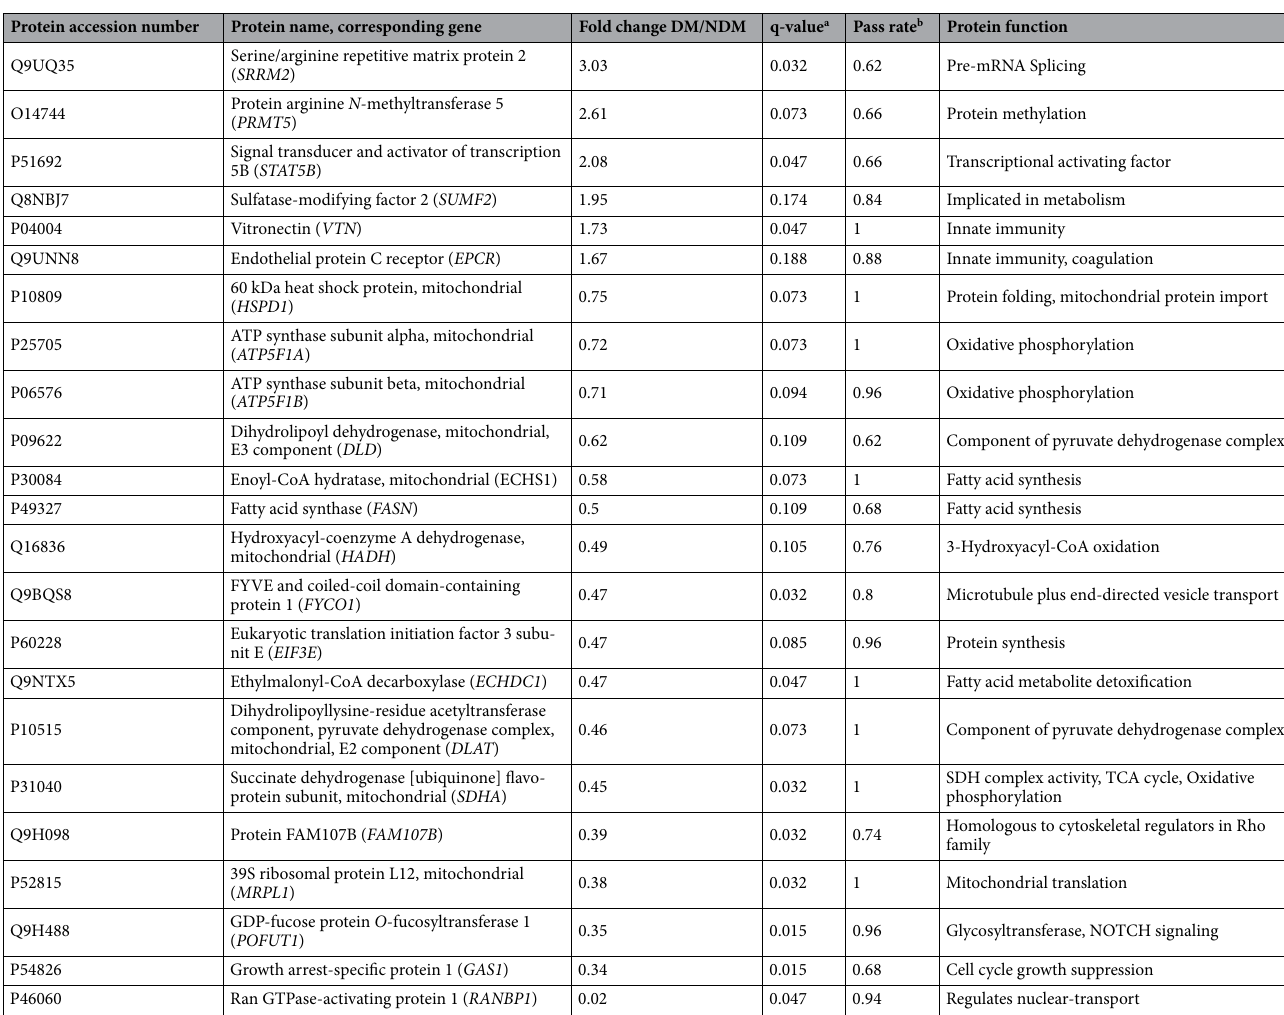
Table 1. Differentially abundant proteins in DM compared with NDM patients. a FDR corrected p-value 50 for differential abundance between DM and NDM tissues (moderated t-test, n = 10). b Fraction of imputations where this protein was significant (q <